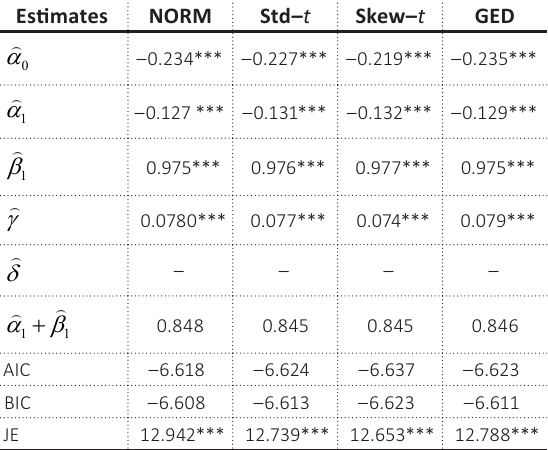
Table 5. ML parameter estimates of EGARCH with different innovation distributions